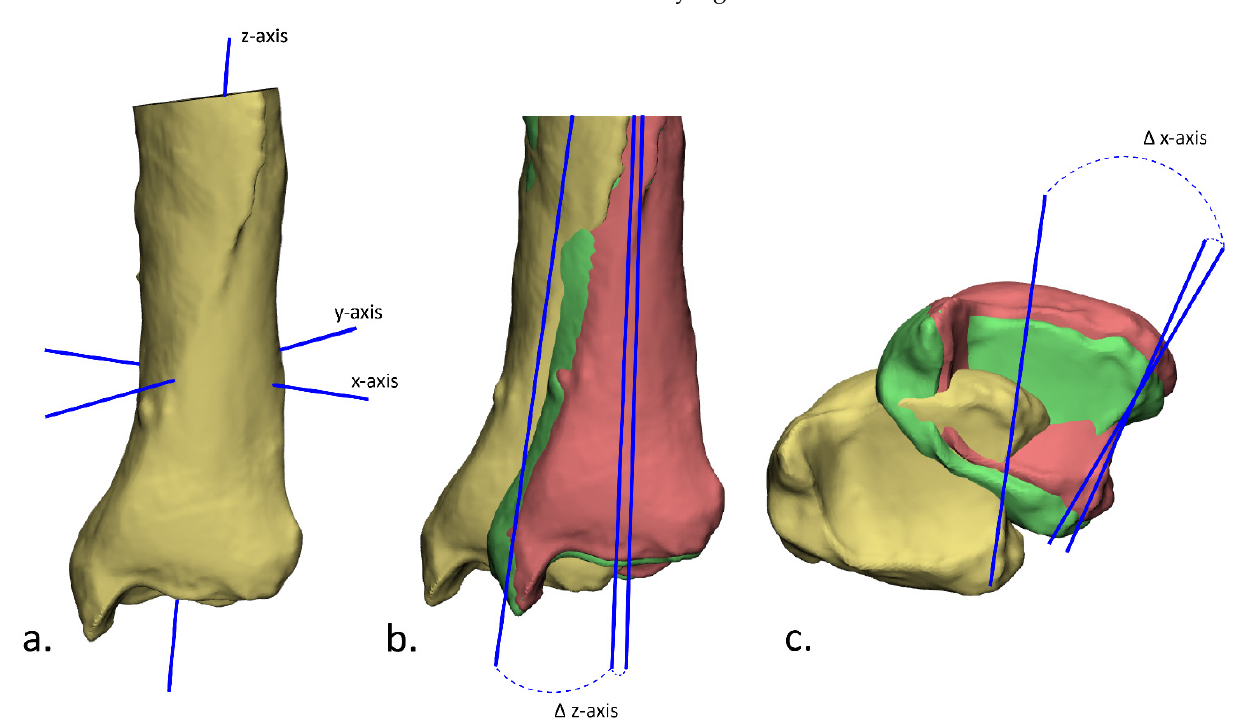
Figure 4. Evaluation of the achieved correction in terms of angulation and rotation. ( a ) First, the inertia axes were determined; ( b ) the angulation was then determined by measuring the angle between the z-axis of the preoperative (yellow) and planned (green) position of the bone, and between the planned and the postoperative (red) position; ( c ) the rotation was determined by measuring the angle between the x-axis of the preoperative and planned position, and the planned and postoperative position.